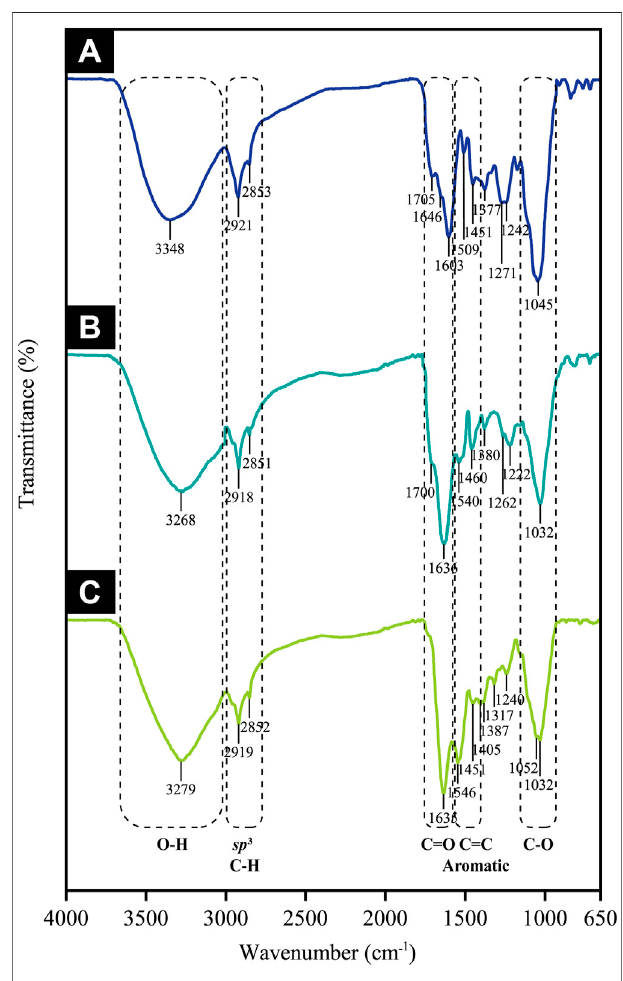
FIGURE 12 | FTIR spectra of (A) CB extract, (B) AuNPs@pH6 and (C) AuNPs@pH10